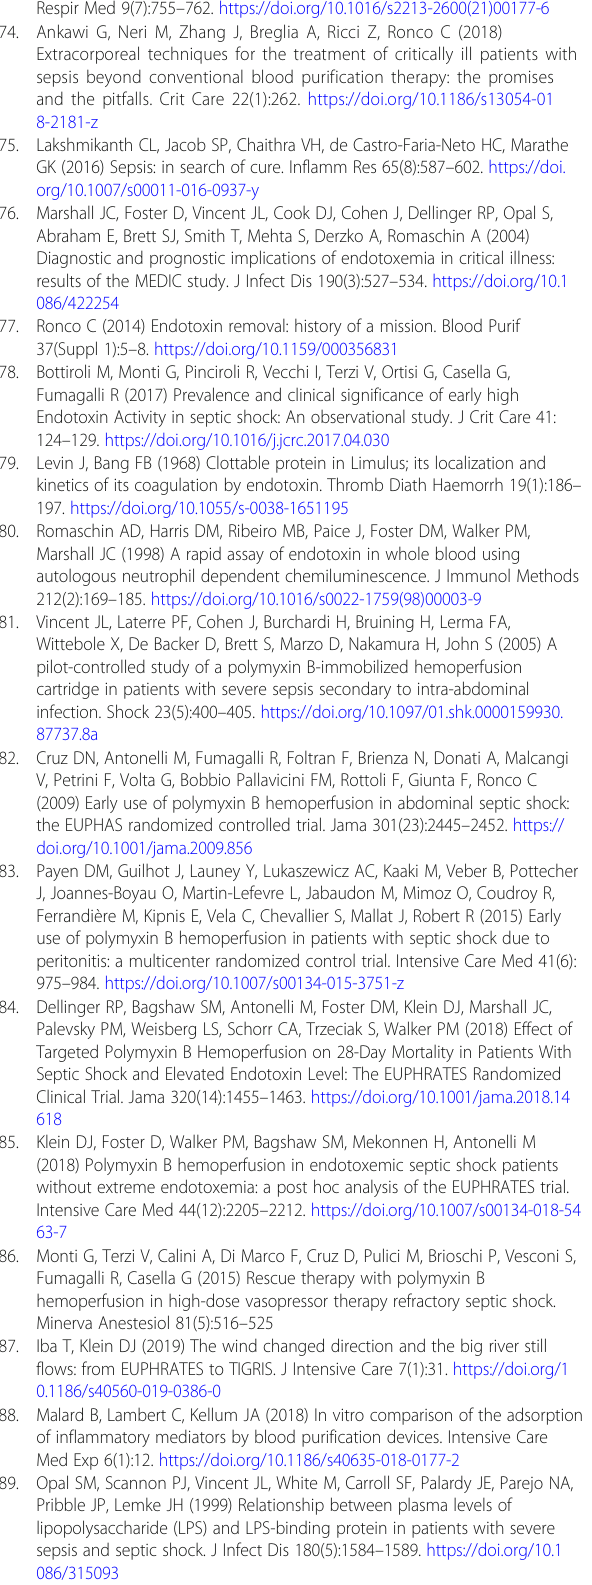
(CYCOV): a single centre, open-label, randomised, controlled trial. Lancet Respir Med 9(7):755 – 762.